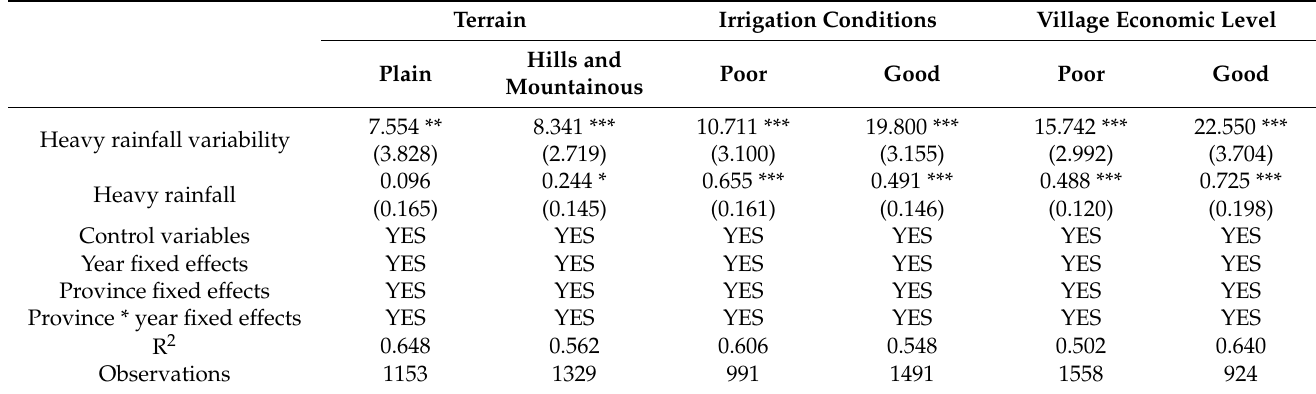
Table 5. Heterogeneous effects of heavy rainfall variability on fertilizer application rates. Terrain Irrigation Conditions Village Economic Level Hills and Poor Good Poor Good Plain Mountainous Heavy rainfall